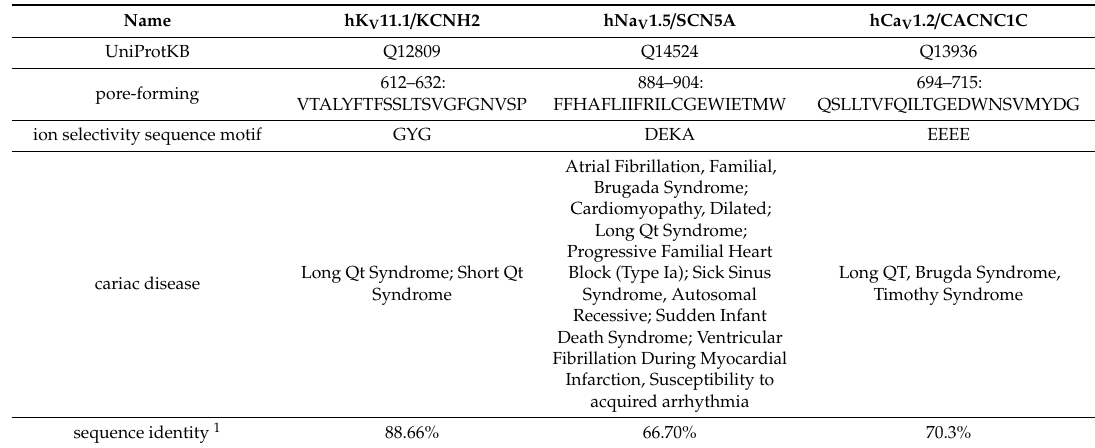
Table 1. Overview of the key properties of the structural subunits of cardiac ion channels